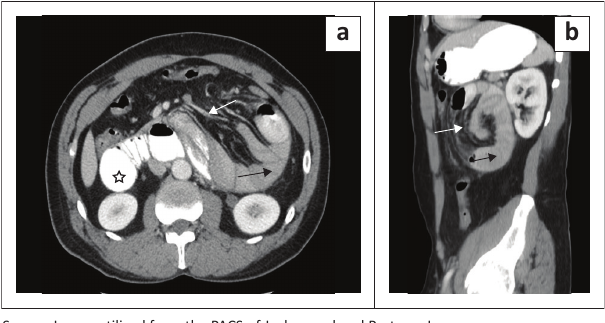
Source : Image utilised from the PACS of Jackpersad and Partners Inc. FIGURE 2 : (a) Axial and (b) sagittal portal venous imaging of the abdomen, demonstrating jejunal loops within the left paraduodenal hernia (black arrow) and stretched mesenteric vessels (white arrow) entering the hernial sac. Dilatation of the proximal duodenum (star) is seen with non-visualisation of a normal duodenal jejunal flexure. Note the position of the left paraduodenal hernia, approximating the posterior margin of the stomach.